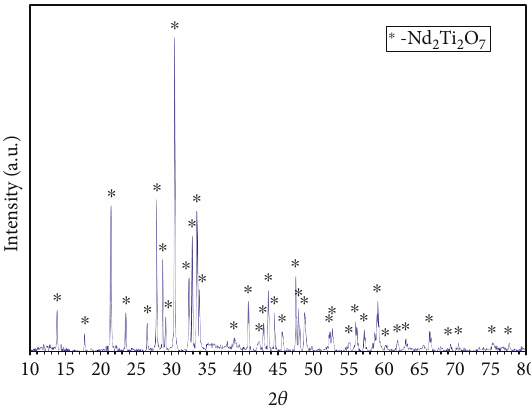
Ti O nanoparticles. Figure 4: FT-IR spectrum of the Nd 2 2 7